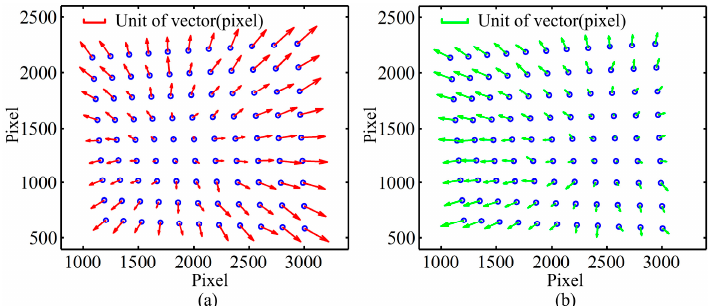
Figure 3. The distances between different printed color circles: ( a ) the relative distances from the red printed circles to the blue ones; ( b ) the relative distances from the green printed circles to the blue ones.